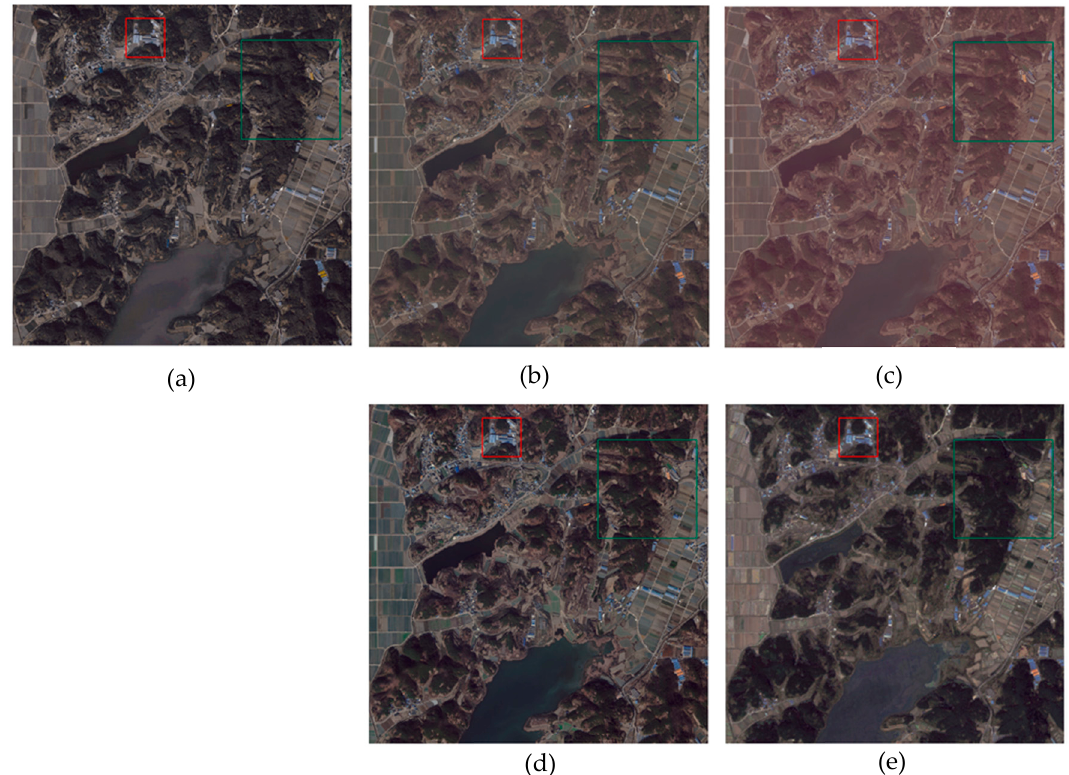
Figure 8. Comparison with the results of relative radiometric normalization for site 3: (a) proposed